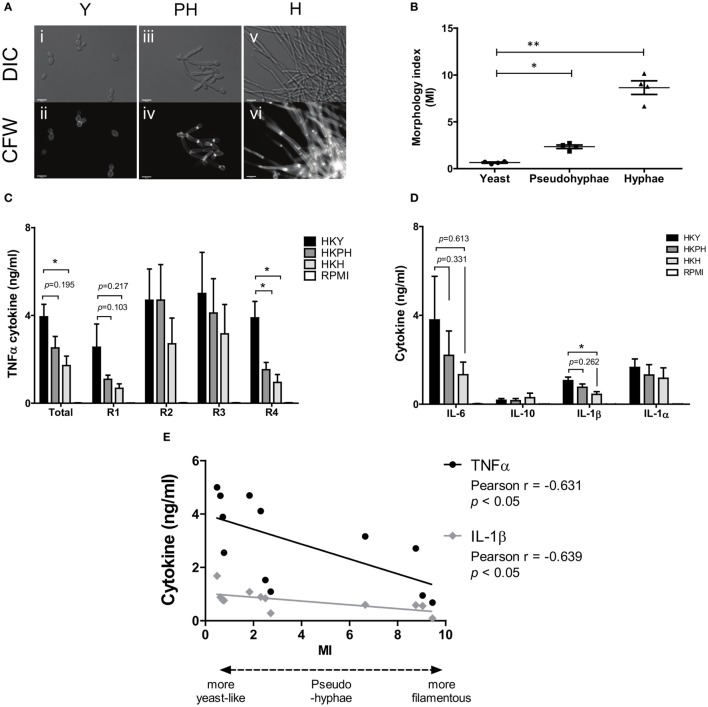
Cytokine production by hPBMCs stimulated by different Candida albicans morphological forms. (A) Yeasts (i–ii), pseudohyphae (iii–iv), or hyphae (v–vi) of C. albicans NGY152 were grown in RPMI 1640 (pH 7) for 6 h at 25, 30, and 37°C, respectively, fixed, and stained with 25 µg/ml CFW to visualize the cell wall. Scale bars = 10 µm. (B) Morphological index (MI) of yeast, pseudohyphal, and hyphal cells was measured. Error bars are SEMs (averages from 50 cell measurements and 4 biological replicates) (*p < 0.05; **p < 0.01). (C) TNFα cytokine production elicited by human peripheral blood mononuclear cells (PBMCs) with HK NGY152 of yeast (Y), pseudohypha (PH), and hypha (H) cells. Each replicate (R1–R4) were averaged as total values. Data are means ± SEM (n > 6; *p < 0.05). (D) IL-6, IL-1β, IL-1α, and IL-10 cytokine production elicited by human PBMCs with HK of yeast (Y), pseudohypha (PH), and hypha (H) cells. Data are means ± SEM (n > 6; *p < 0.05). (E) Correlation between TNFα or IL-1β cytokine and MI. Results are Person R values (n = 4 biological replica).